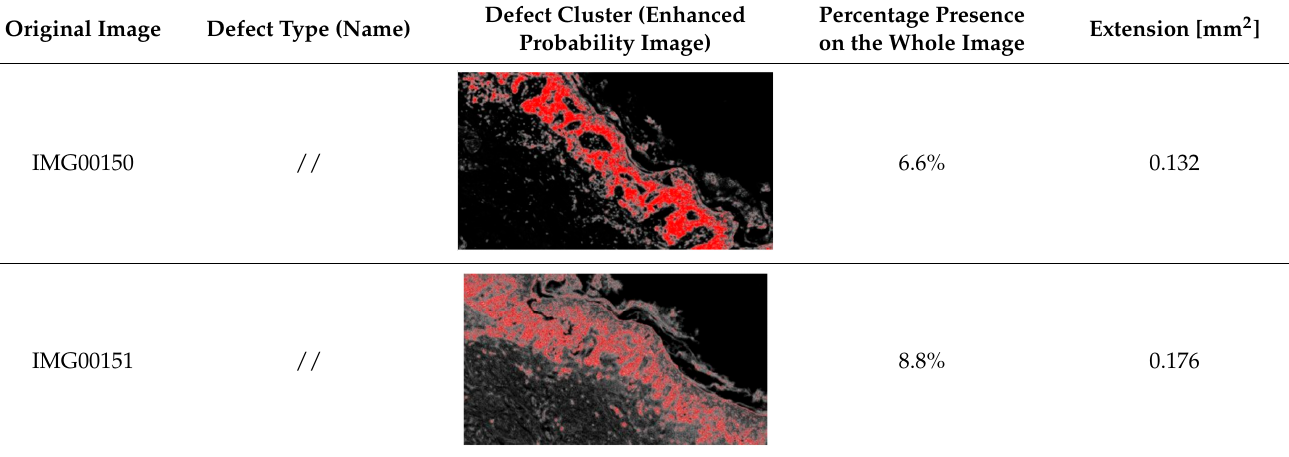
Table 3. Example of two other images whose cytological characteristics were studied, including: cellular atypia, eventual pagetoid spreading, mitosis and nuclear pleomorphism.